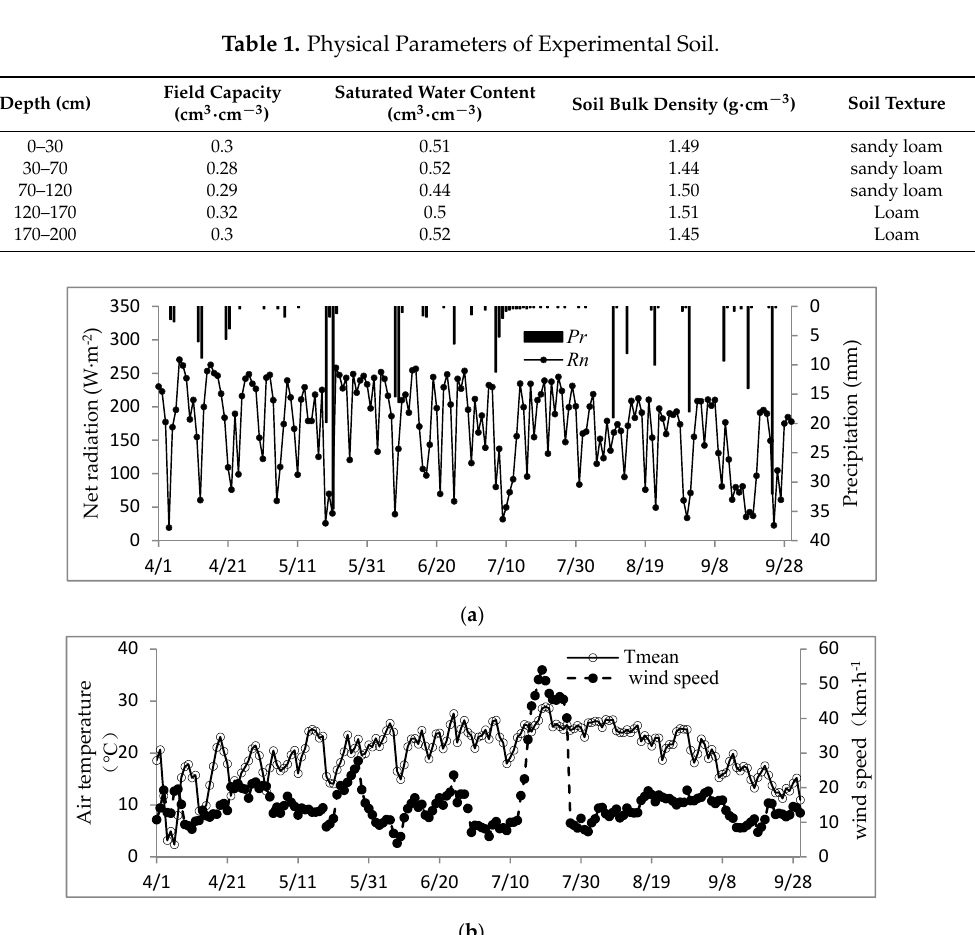
Table 1. Physical Parameters of Experimental Soil.